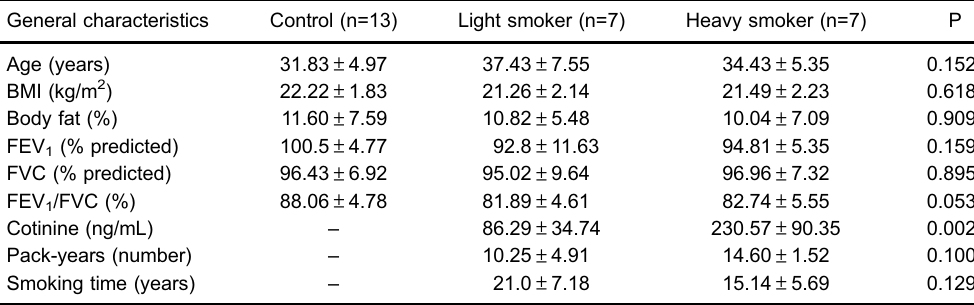
Table 1. General characteristics of smokers and control subjects.